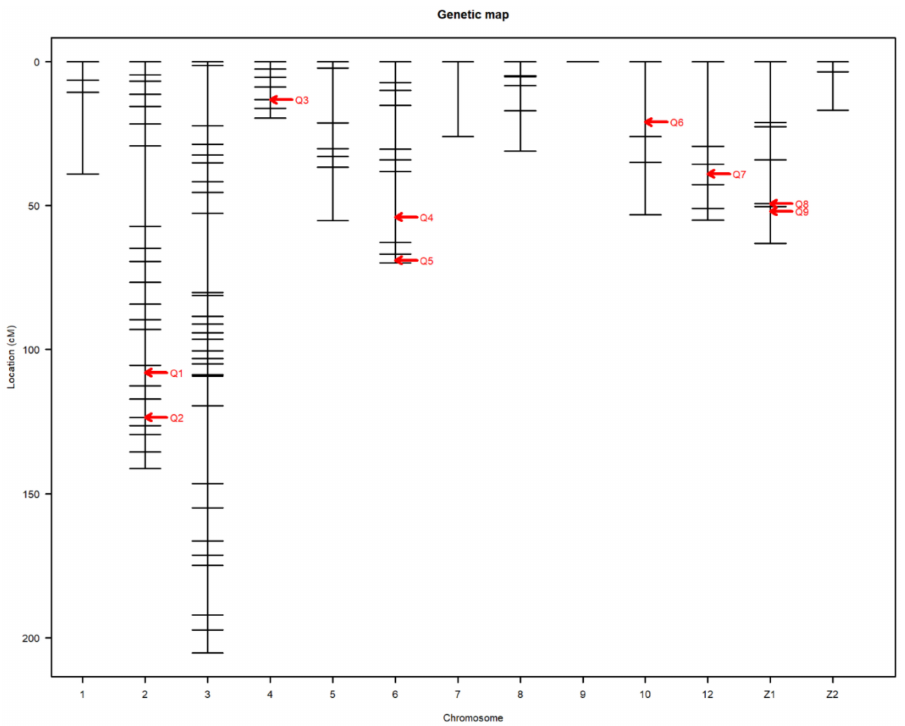
Figure 6. Detected QTL presented in the genetic map. The abscissa shows the chromosome number. The ordinate represents the position of the markers based on cM. Q stands for the QTL